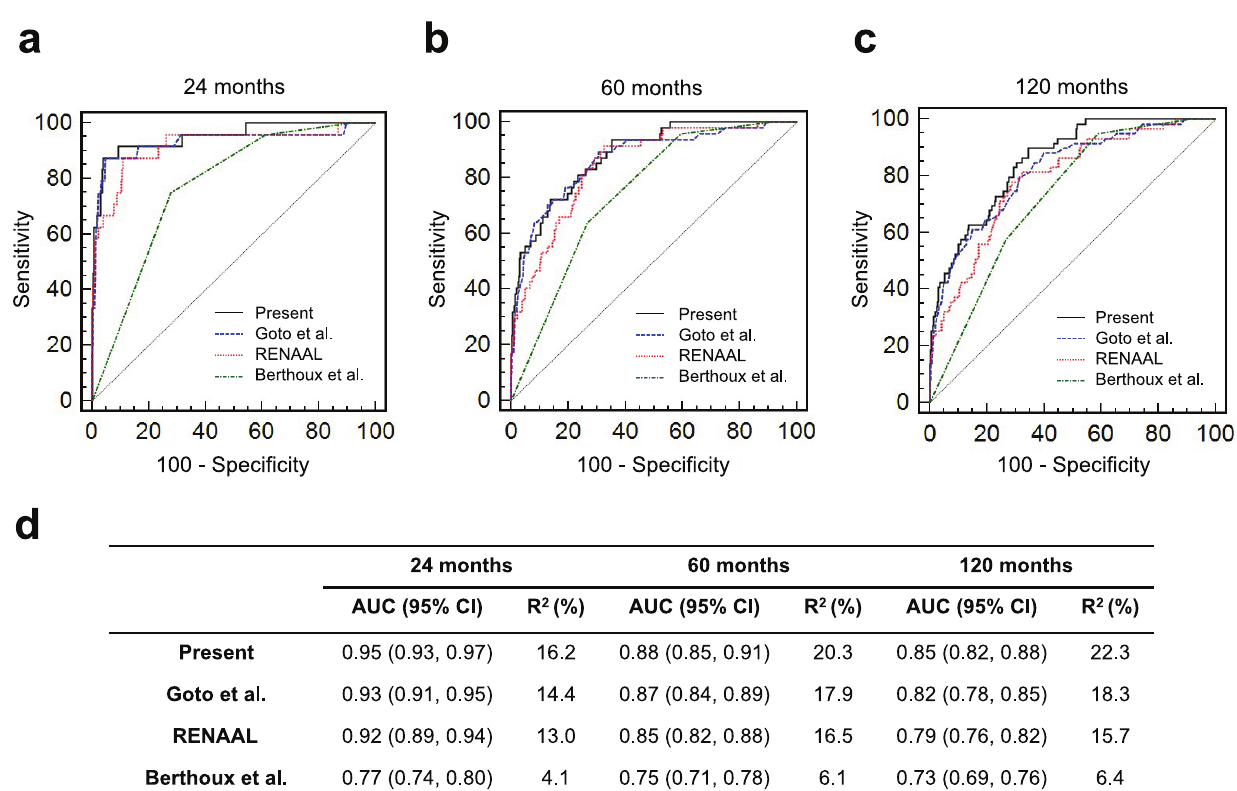
Figure 4. Performance of the Published ESRD Prediction Scores. The ROC curves for predicting renal outcomes within (a) 24 months, (b) 60 months, and (c) 120 months of follow-up. The Risk Score from this study (black) is contrasted against the Goto et al. score (blue), RENAAL score (red) and the Berthoux et al. score (green); (d) comparisons of AUCs (and their 95% CIs) and R 2 for the four risk score prediction models.